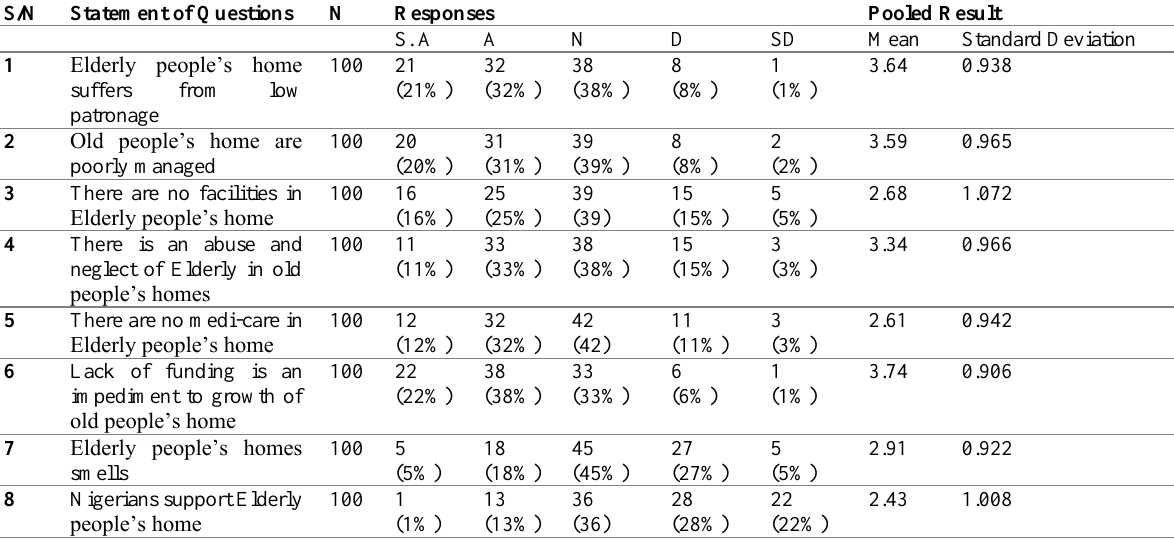
Table 2: Development of elderly people’s